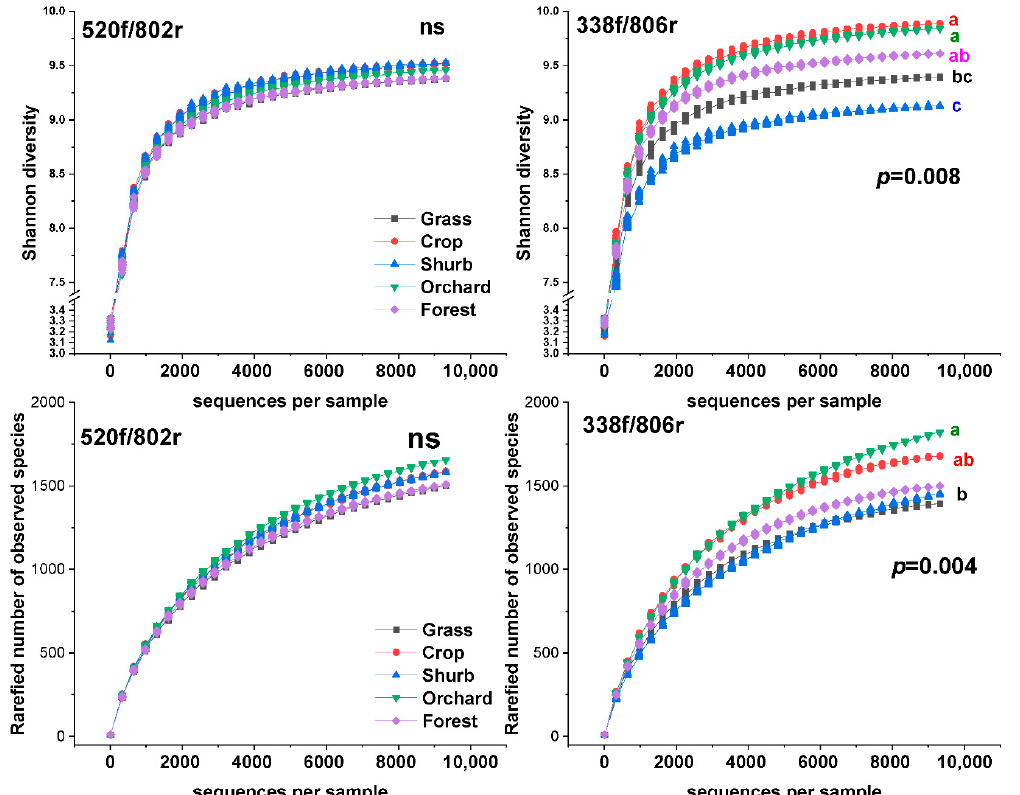
Figure 1. The Shannon diversity index and richness of soil bacteria in different land uses on the Loess Plateau. Primer pair 520f/802r targeted the V4 region of the 16S rRNA gene; primer pair 338f/806r targeted the V3 – V4 region of the 16S rRNA gene. Ns, no significant difference. Table 1. The impacts of environmental factors on the soil bacterial diversity of sequences obtained using the 338f/806r primer set targeting the V3 – V4 region.